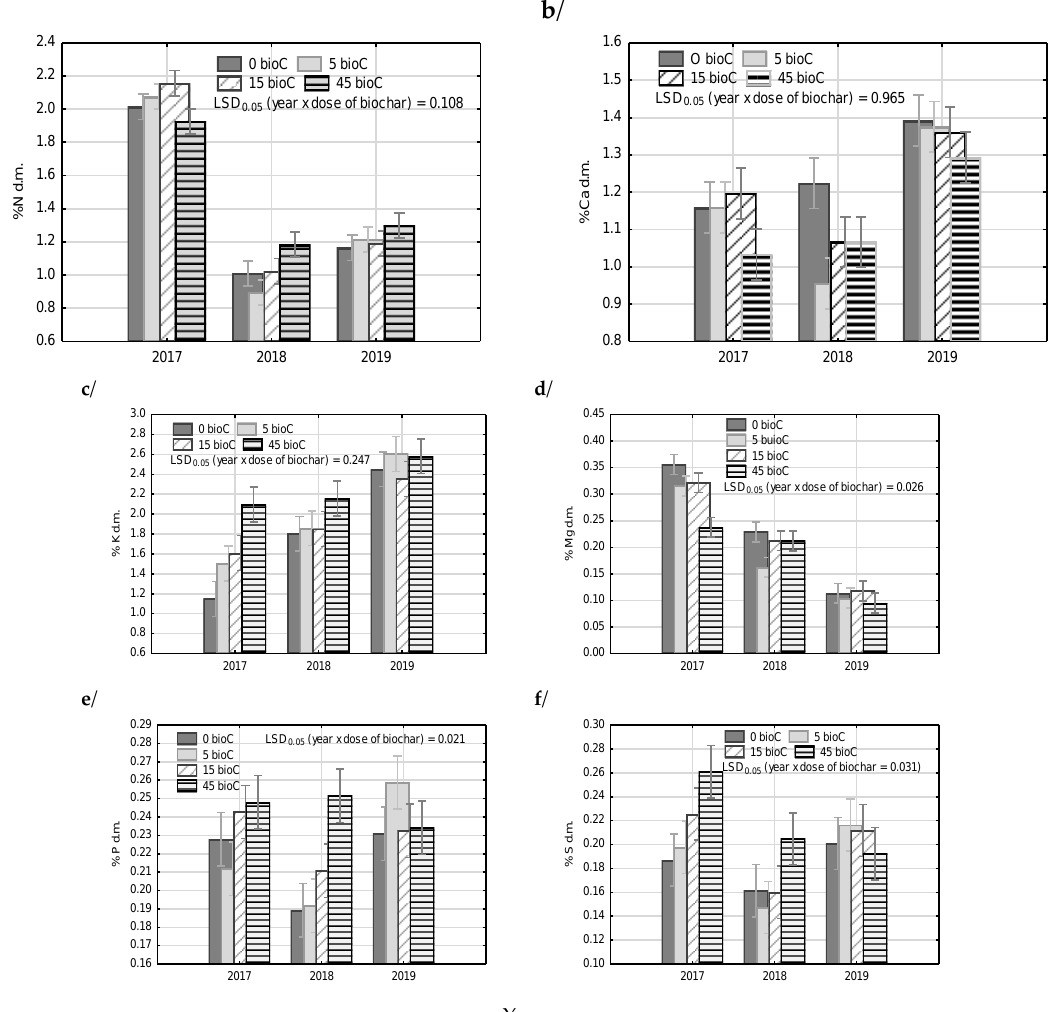
Figure 5. Contents of nitrogen, calcium, potassium, magnesium, phosphorus, and sulfur (%DM) in mint biomass depending on the applied biochar dose in 2017 – 2019 (average of fertilizer nitrogen doses); the factors were separated using the Fisher test ( p < 0.05). Rajkovich et al. [18] found that tissue N concentration and total N uptake by corn in a greenhouse experiment decreased, on average, with increasing pyrolysis temperature and biochar application rate. During the second and third year of this study, mint contained the highest amount of N from the cultivation site where 45 tons of biochar ha -1 were used. The obtained results are consistent with the those of Jones et al. [3], who reported that wood biochar (0.25 and 50 t ha − 1 ) used in sandy loam clay soil affected foliar N only during the second and third years after addition. In soils without biochar, nitrogen fertilization in higher doses (100 kg N ha -1 and 125 kg N ha − 1 ) significantly increased the N content in the plant material as compared with the dose of 75 kg N. In combination with the lowest dose of biochar (5 t ha − 1 ), only the dose of 125 kg N ha − 1 significantly increased the N concentration in biomass in relation to the others. For the doses of 15 and 45 tons of biochar per hectare, nitrogen was most effectively used in fertilization performed at doses of 100 and 125 kg N ha − 1 . These results correlate with the highest content of nitrate nitrogen in soil in these combinations (Figure 4a). The most proportional increase in the N concentration in the mint along with increasing dose of fertilizing nitrogen was observed when using biochar at the highest dose (Figure 6a).